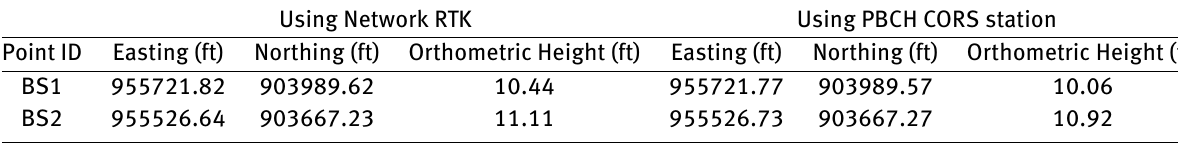
Table 1: Coordinates of control points occupied by base station obtained using Network RTK and PBCH CORS station.